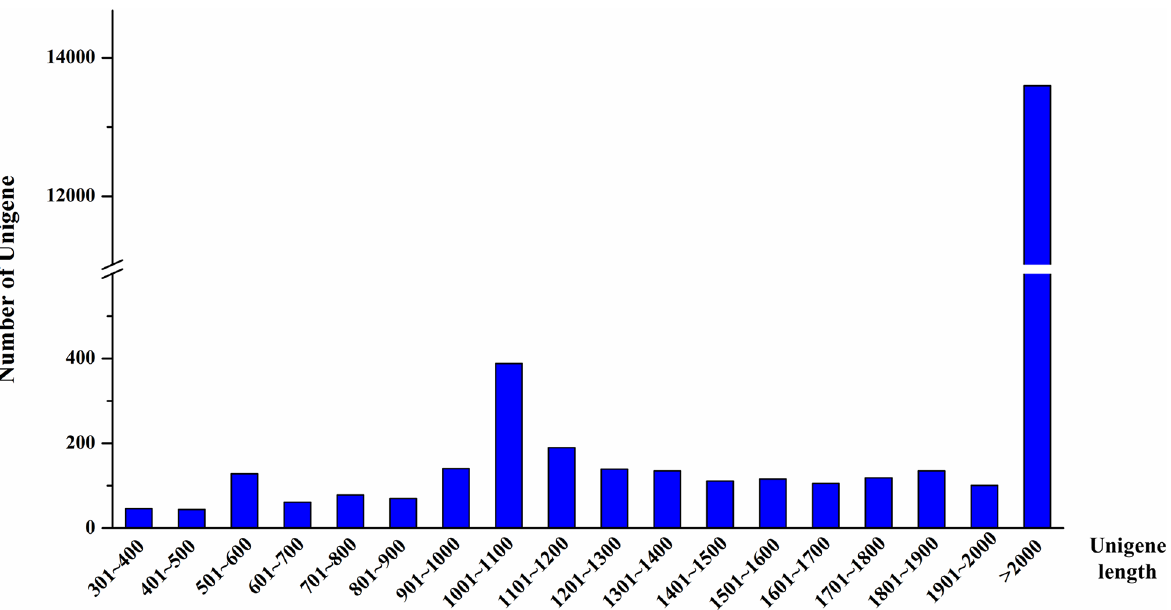
Fig 1. Histogram of unigene length distribution. The x-axis indicates the length range of unigenes; the y-axis denotes the number of unigenes.